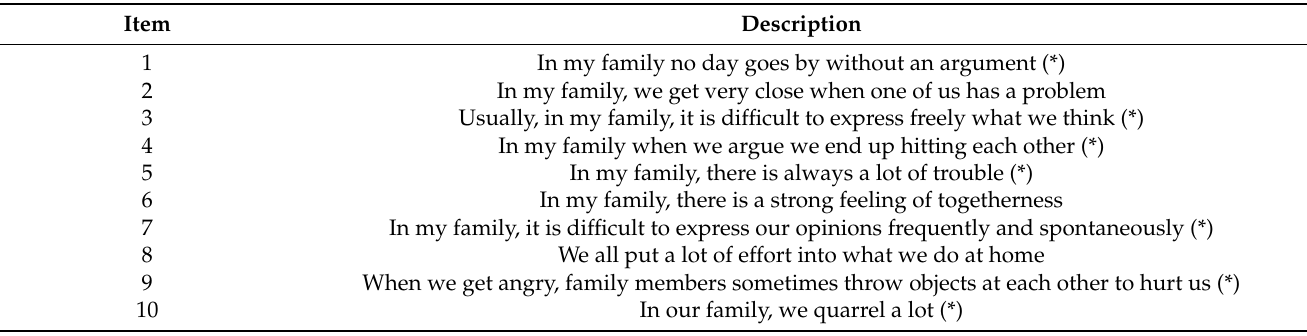
Table 1. Items included in the scale of family